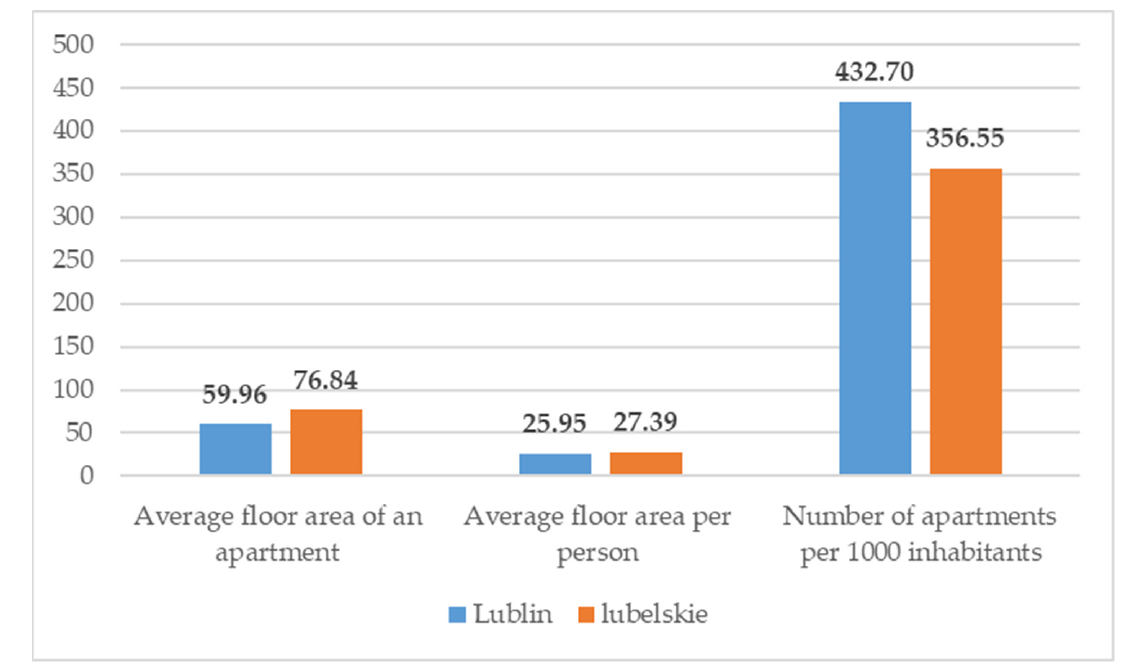
Figure 10. Indicators of housing infrastructure availability in Lublin and the Lublin Province.